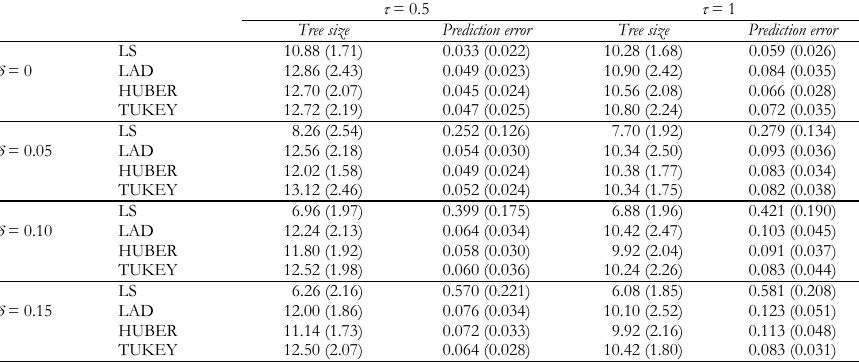
Mean and standard deviation (in brackets) of the tree sizes and the prediction errors over 50 replications n= 1500 τ = 0.5 τ = 1 Tree